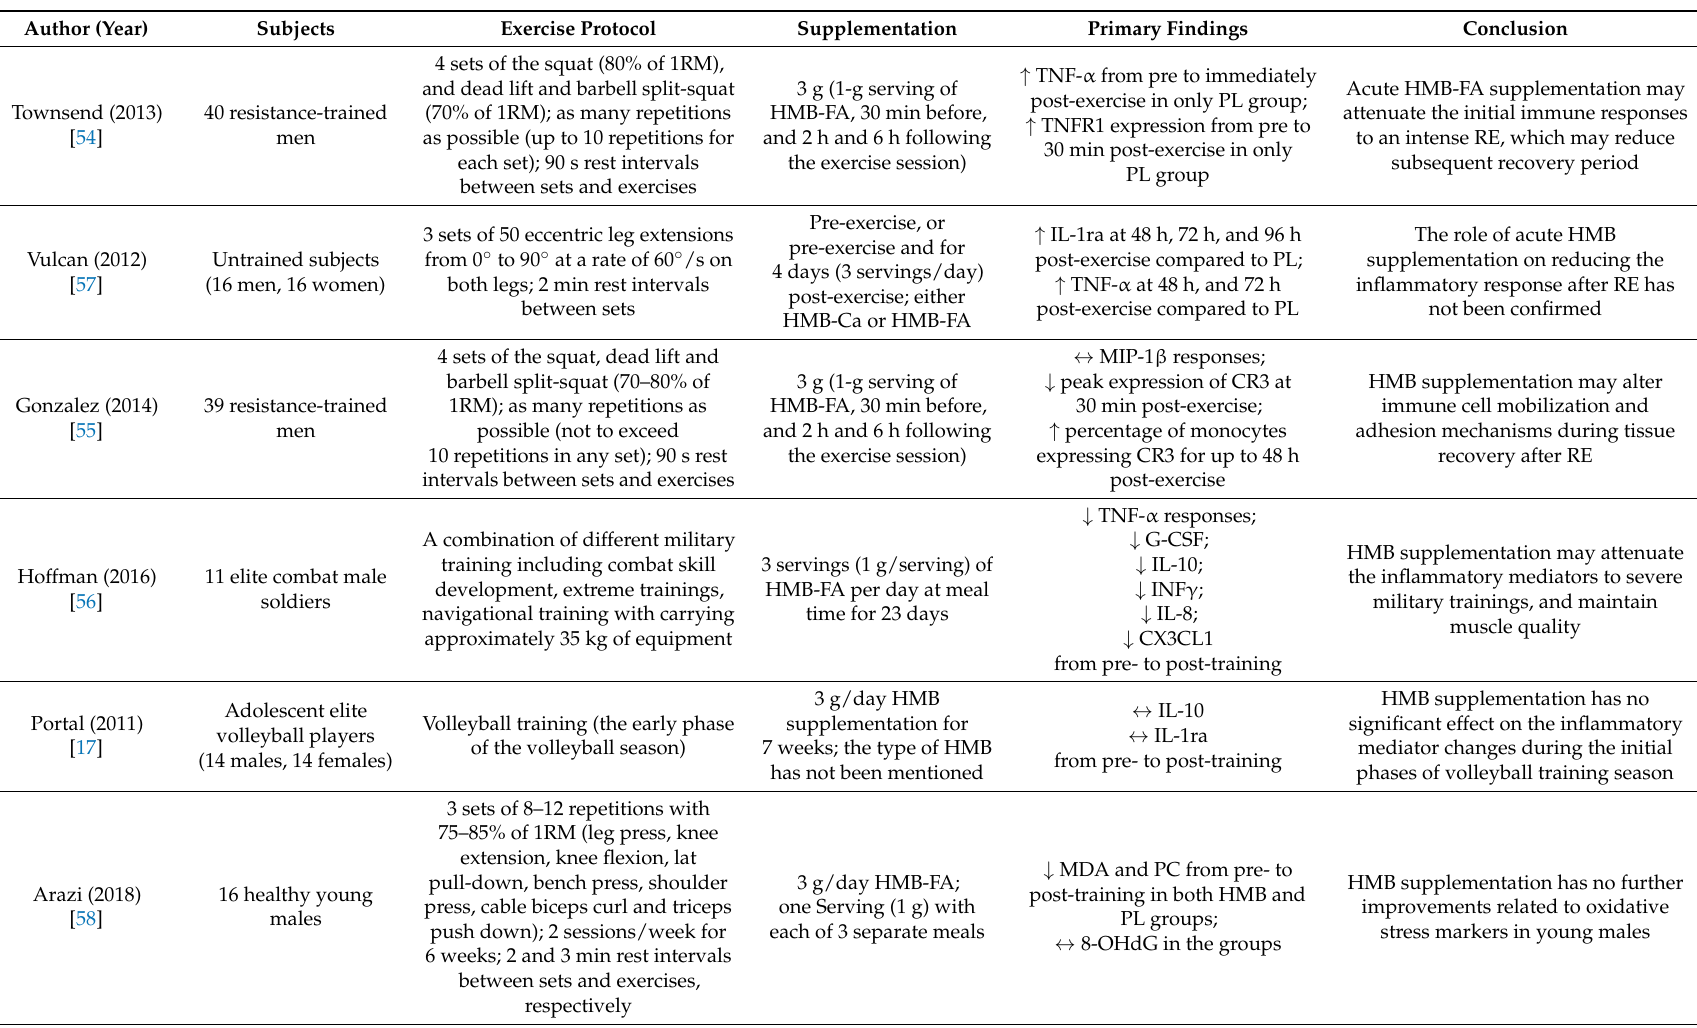
Table 2. Main characteristics of studies examining the effects of HMB supplementation on inflammatory, cardiovascular, and oxidative stress